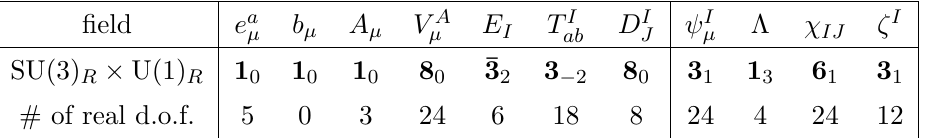
Table 6 . Field content of the Weyl multiplet in N = 3 conformal